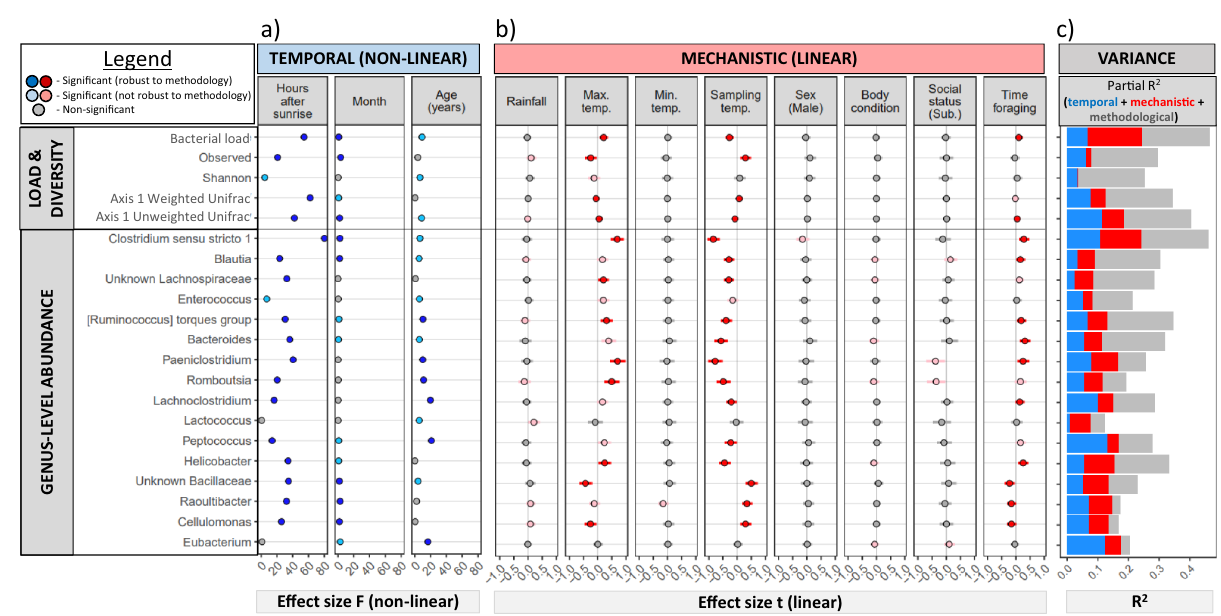
Fig. 5 Summary of temporal (blue) and mechanistic (red) effects on the microbiome ( n = 1109). a Effect sizes for non-linear temporal variables on bacterial load, diversity measures, and abundances of 16 focus genera. b Effect sizes and 95% con fi dence intervals for eight environmental, biological, and behavioural variables. Dark blue/red denotes signi fi cant associations that are consistent across storage treatments, whilst light blue/red denotes signi fi cant yet inconsistent across storage. c Partitioning of model R 2 into variance explained by temporal, mechanistic, and methodological variables. Source data are provided in the source data fi